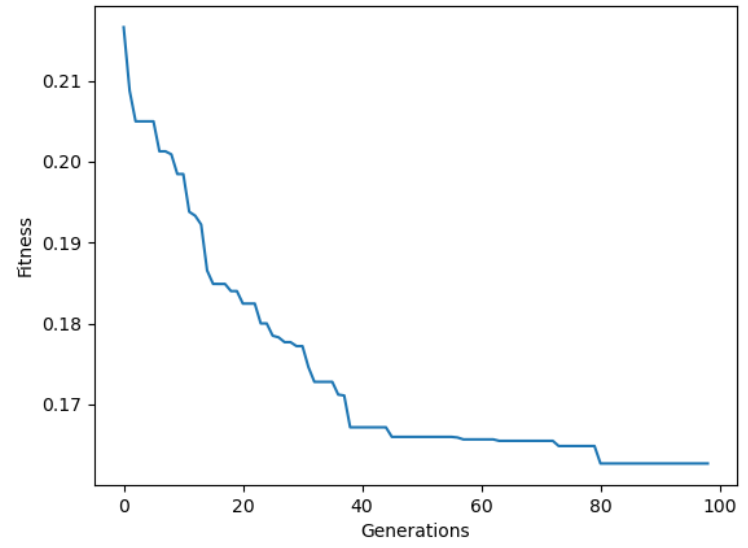
Figure 2. Fitness values for each generation (GA1).